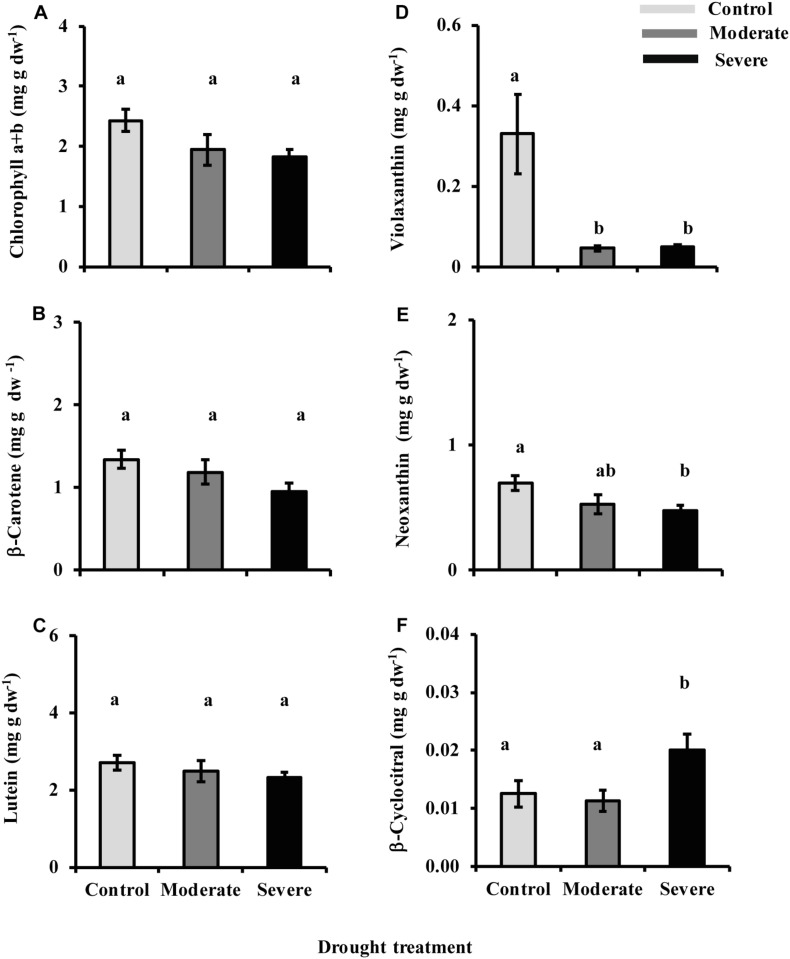
Drought influences chlorophyll and carotenoid levels. Presented are data for (A) chlorophyll a and chlorophyll b, (B) β-carotene, (C) lutein, (D) violaxanthin, and (E) neoxanthin measured by HPLC-UV, and (F) β-cyclocitral measured by LC-MS. Data shown are means of five biological replicate ± SE. Different letters indicate significant differences at P < 0.05.